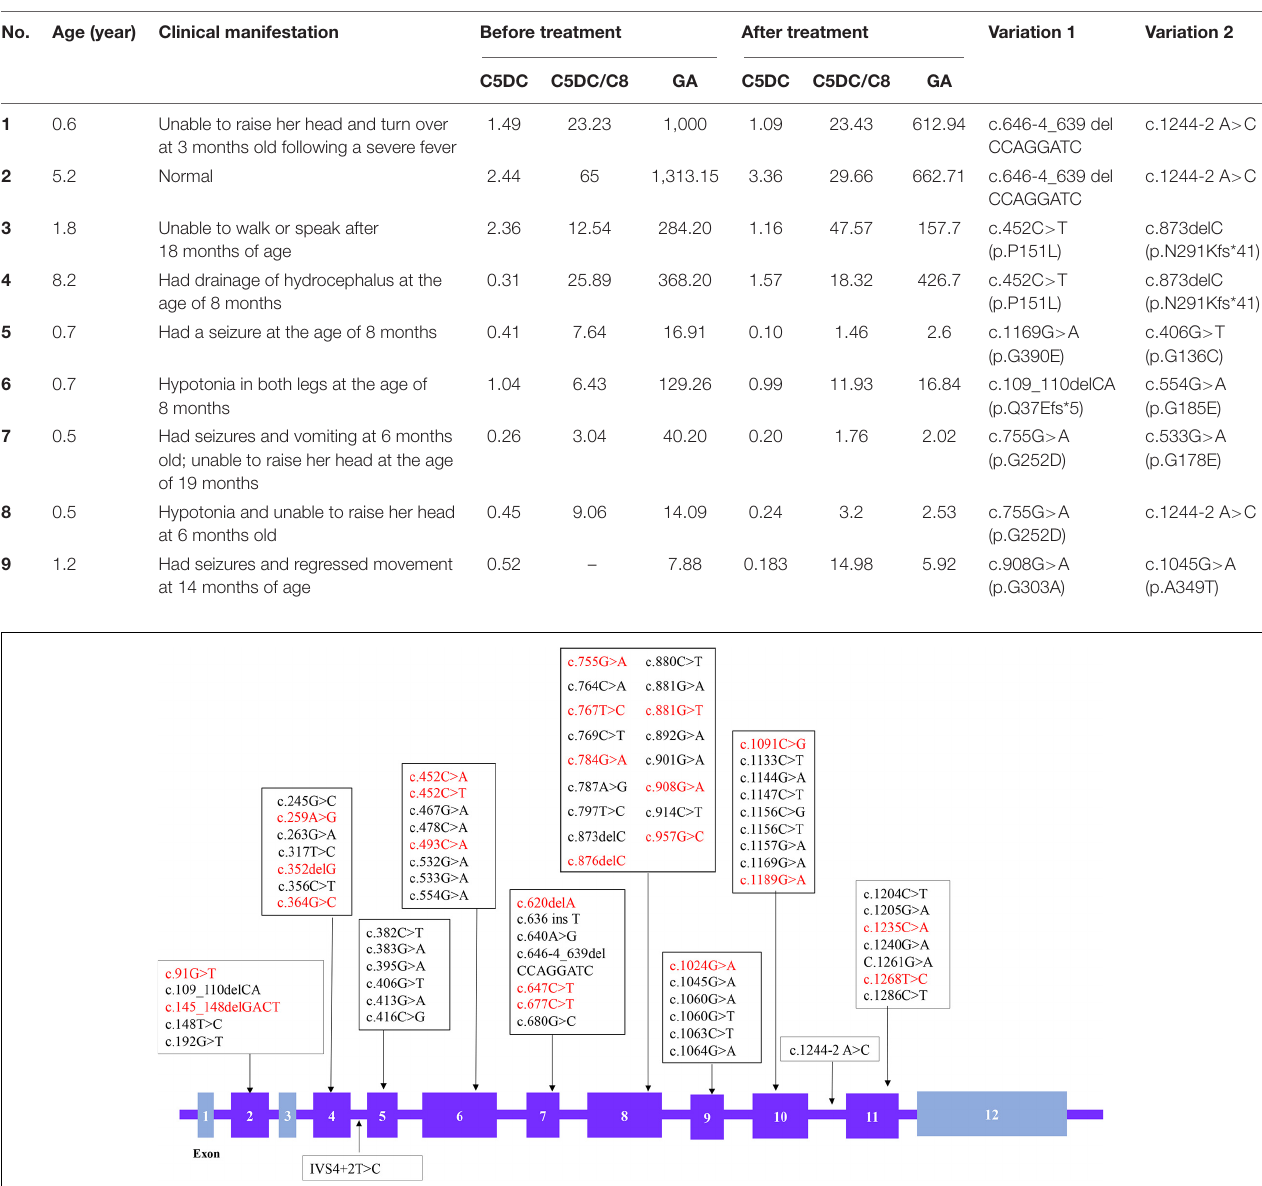
TABLE 3 | Phenotype and biochemical results for nine patients with unmatched manifestations. No. Age (year) Clinical